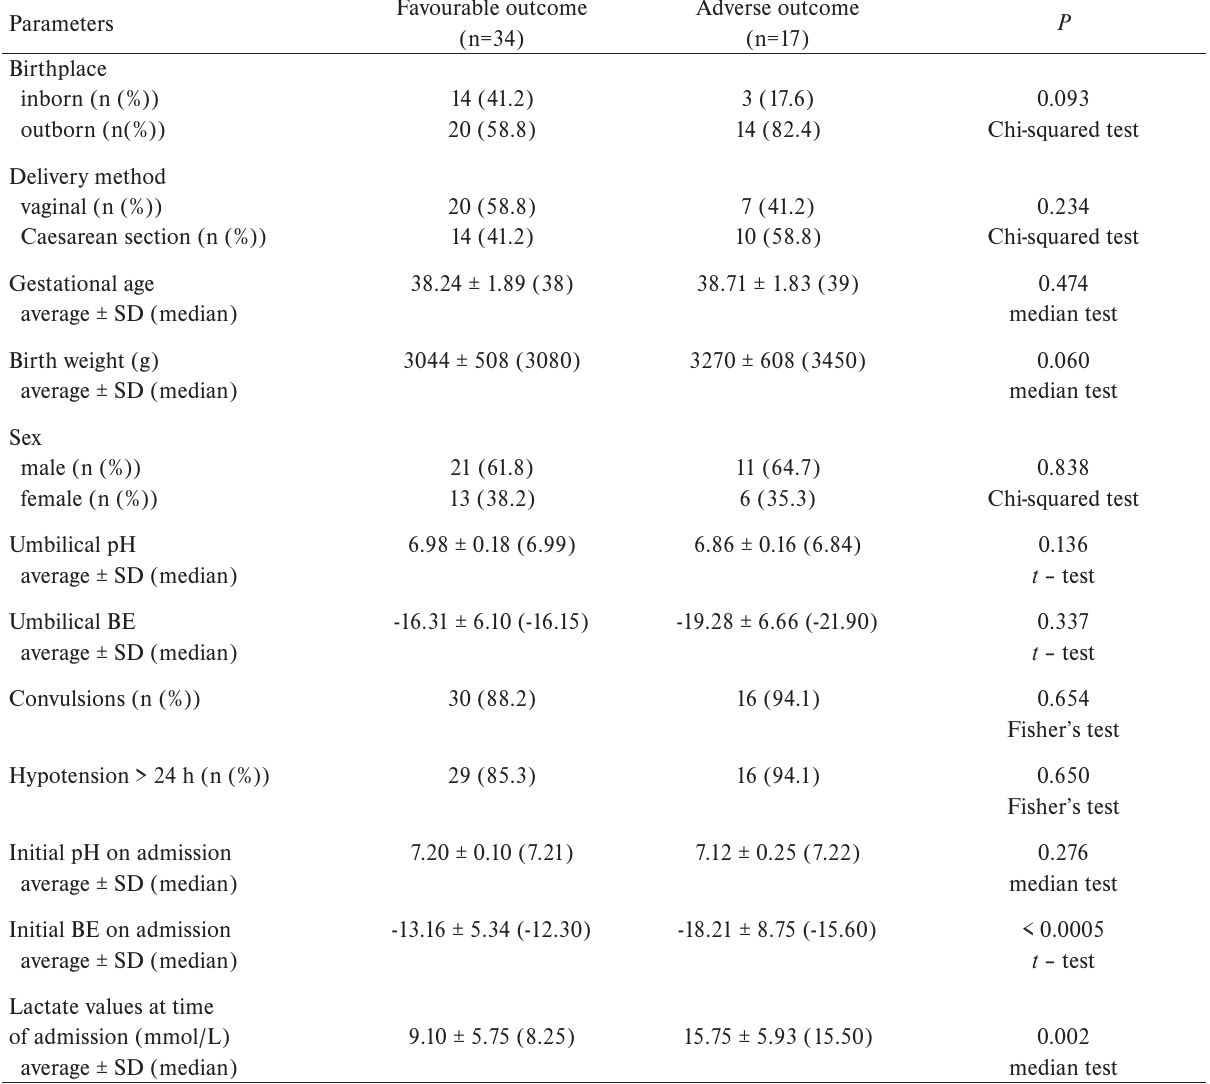
Table 1. Initial parameters of patients selected for the